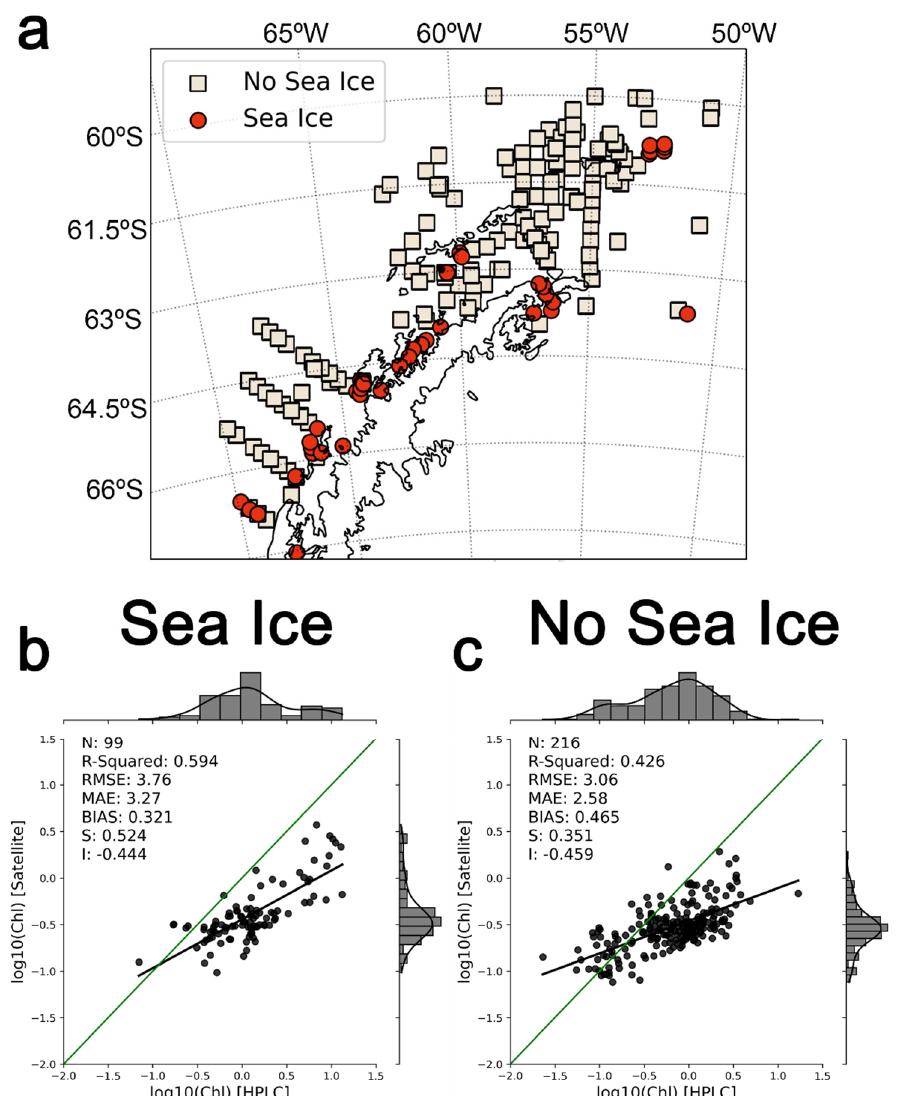
Figure 6. Spatial distribution of the match-ups adjacent to sea ice (<5 km) ( a ); CCI 4.2. product performance for match-ups closer than 5 km to sea ice ( b ) and with no adjacent sea ice ( c ). The green line represents the 1:1 line (ideal correspondence).